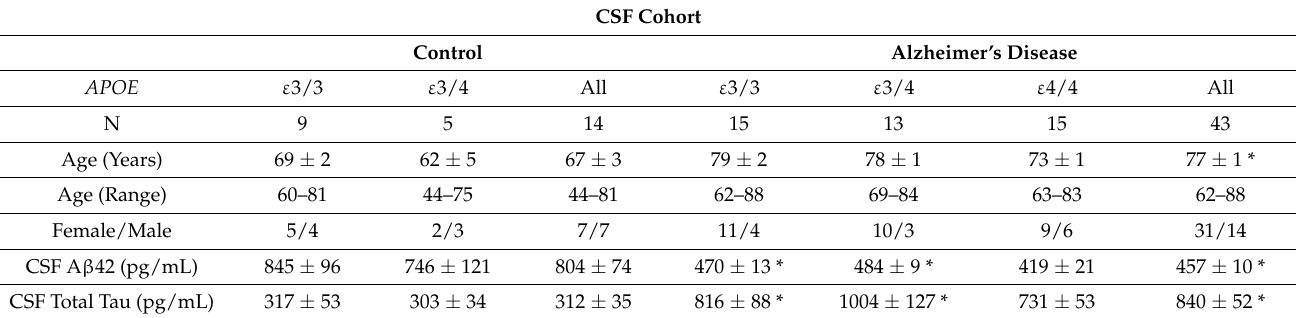
Table 1. Clinical and demographic data, as well as classic CSF biomarkers, for the samples used in this study. F, female; M, male. The data represent means ± SEM. Significant difference was * p < 0.0001, with respect to the NDC